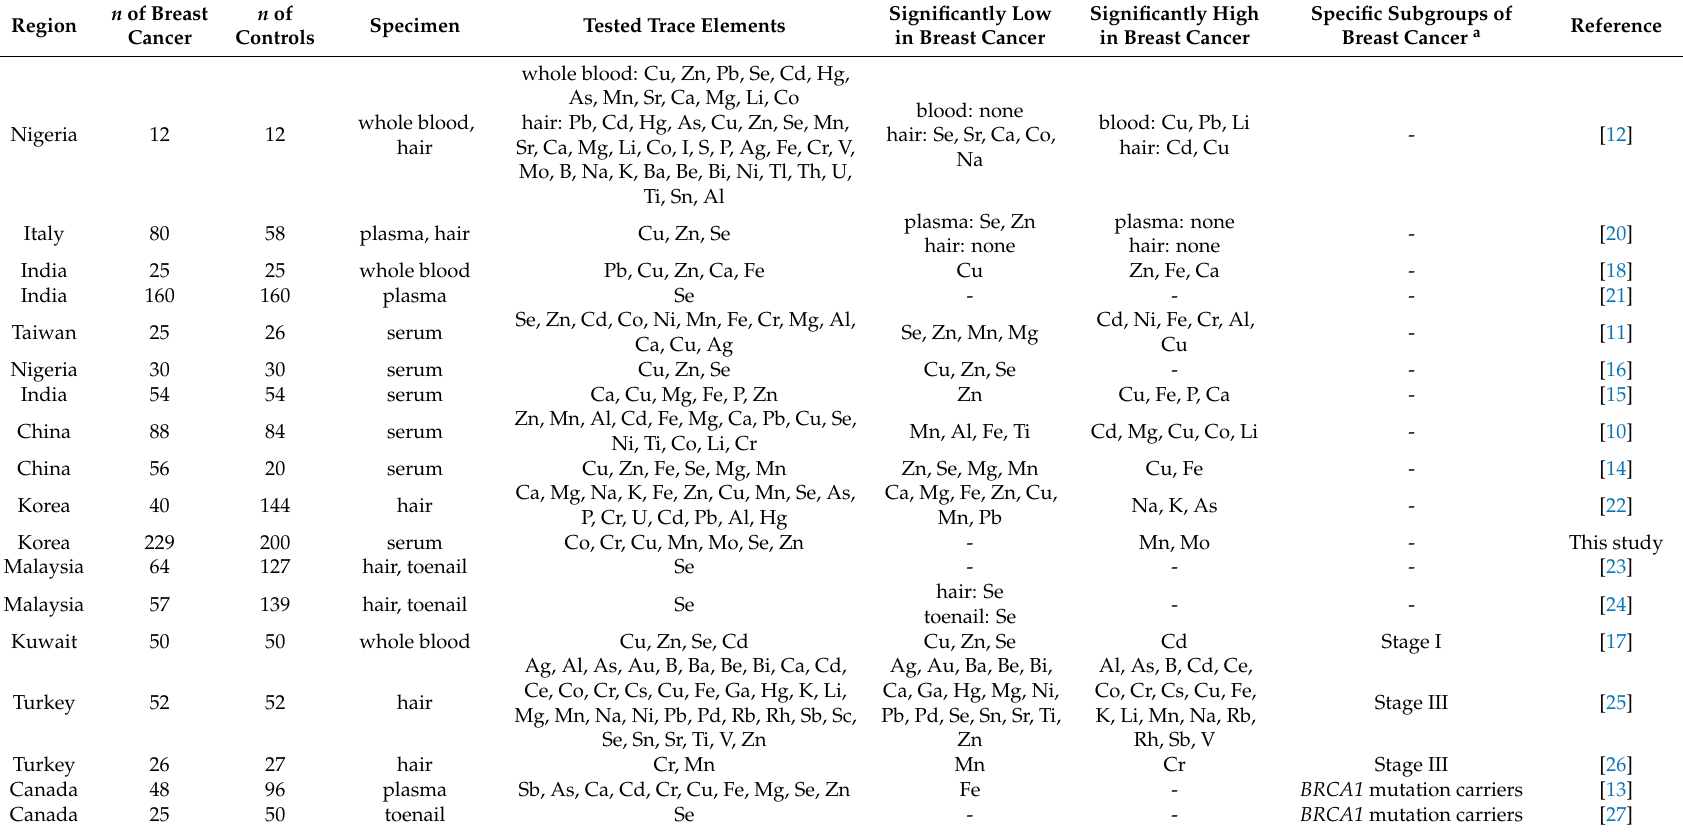
Table 3. Previous studies of trace elements in breast cancer patients compared to